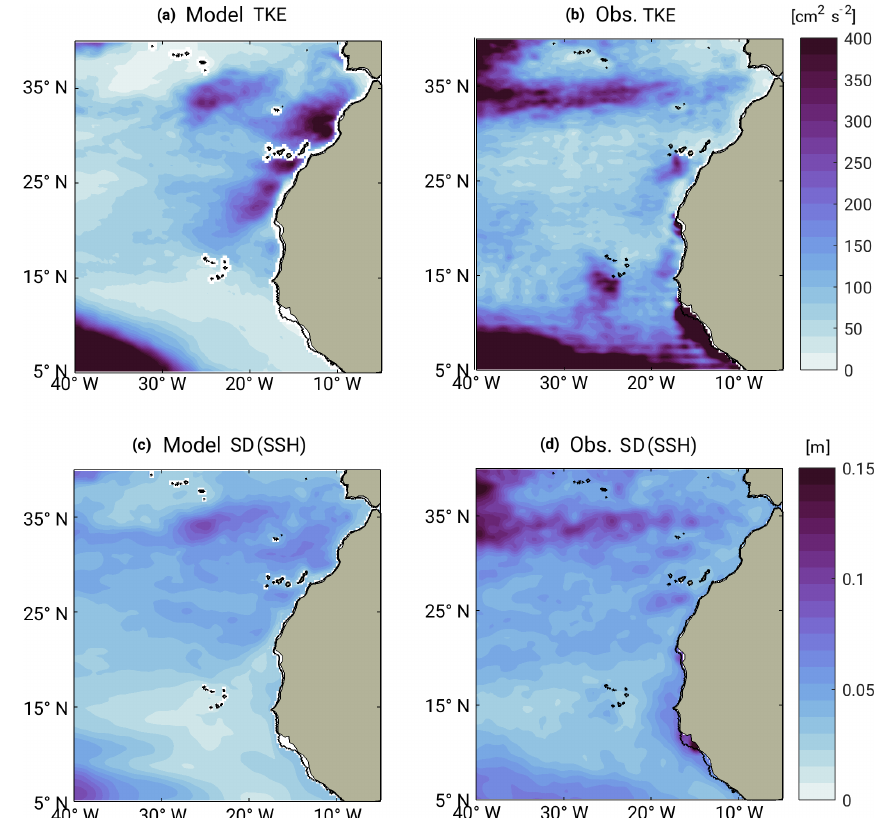
Figure 2. Comparison of (a) modeled ROMS and (b) observed AVISO Turbulent Kinetic Energy, TKE [cm 2 s − 2 ]; comparison of (c) modeled ROMS and (d) observed AVISO standard deviation of SSH, STD(SSH) [m]. Modeled velocities were calculated offline using geostrophy from modeled SSH and regridded on the AVISO DUACS 2014 product grid, 1/4 ◦ resolution. TKE was calculated from bi-daily (ROMS) and daily (AVISO) turbulent velocities, defined as differences of the total fields from the monthly climatology interpolated to daily (AVISO) or bi-daily (ROMS) time resolution. A detailed description of the data used is provided in Appendix A: Datasets, Table